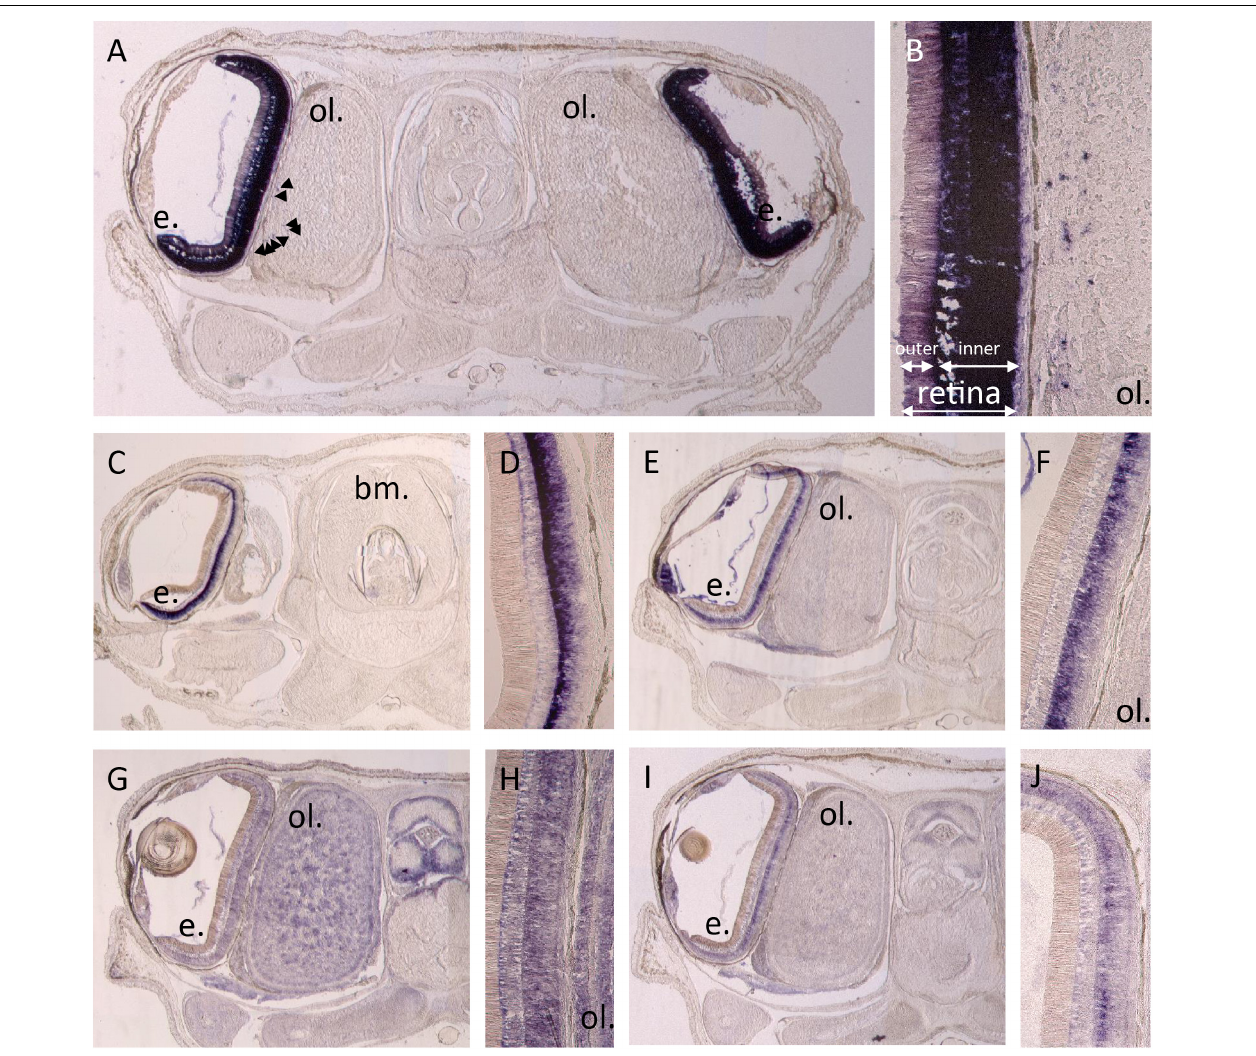
FIGURE 6 | In situ hybridization of r-opsin1 (A,B) , retinochrome 1 (C,D) , retinochrome 2 (E,F) and cryptochromes: CRY 123 (G,H) and CRY 6 (I,J) . Pictures (A,C,E,G,I) show a 20 µ m section of an embryo head with brain (not on section A,C ), optic lobes (not on section C ) and eyes including retina and sometimes the lens. Pictures (B,D,F,H,J) are a magnification focused on the retina ± the side of the optic lobes. All pictures were taken after 11 h of revelation except CRY 123 pictures which were taken after 5h30. Arrows point some small stained spots. e. = eye, ol. = optic lobe, bm. = buccal mass.